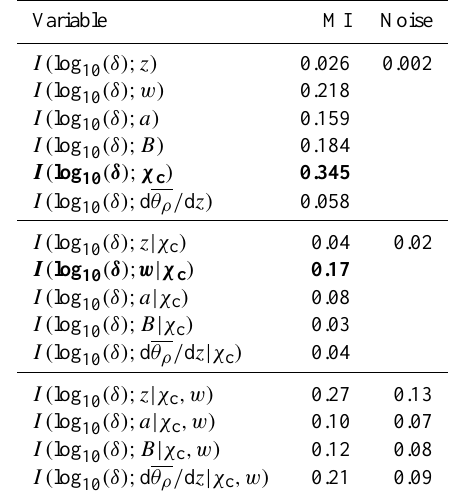
Table 3. Mutual information between log 10 (δ) and various cloud core properties for individual clouds in the combined BOMEX and ARM LES output. Noise level is found by taking the maximum of 100 Monte Carlo trials of mutual information between log 10 (δ) and a random permutation of each variable. Maximum mutual informa- tion values in each comparison category are in